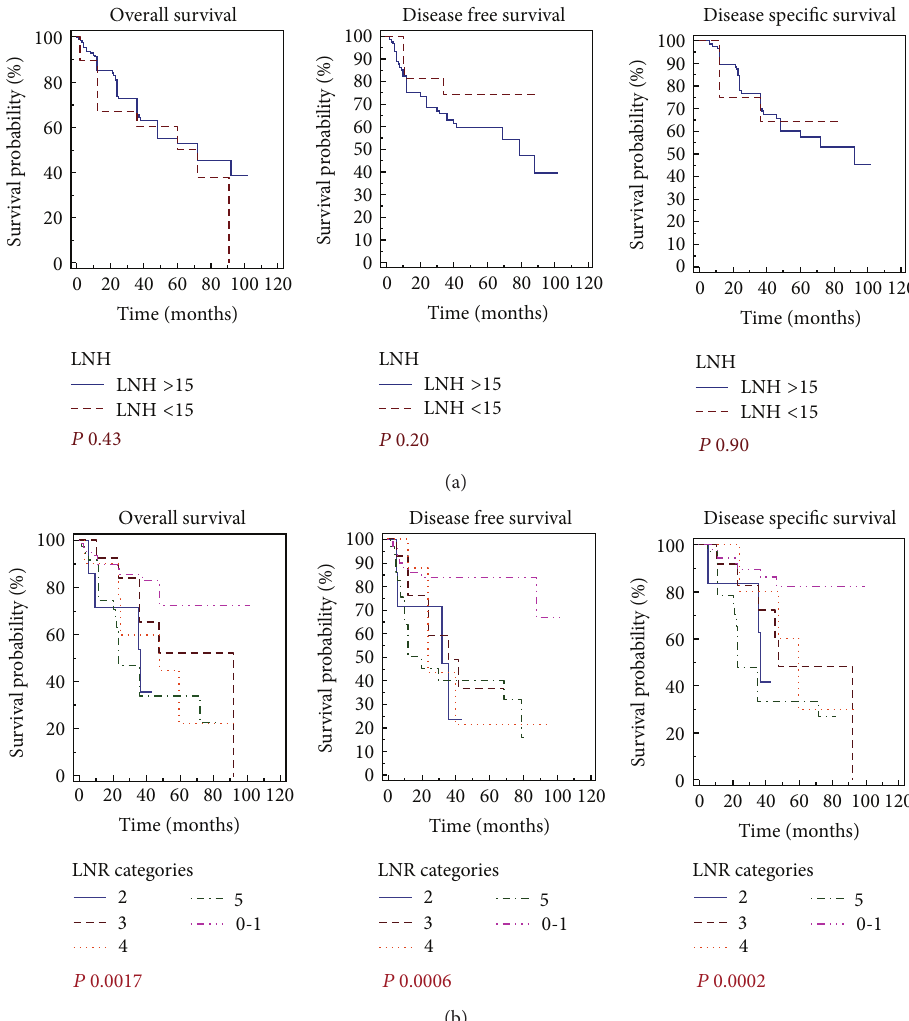
Figure 3: Gastric cancer and LNR/LNH related survivals. (a) Overall survival, disease free survival, and disease specific survival of R0 gastric resection for adenocarcinoma of the stomach according with the LNH subgroups; (b) overall survival, disease free survival, and disease specific survival analysis according to the LNR